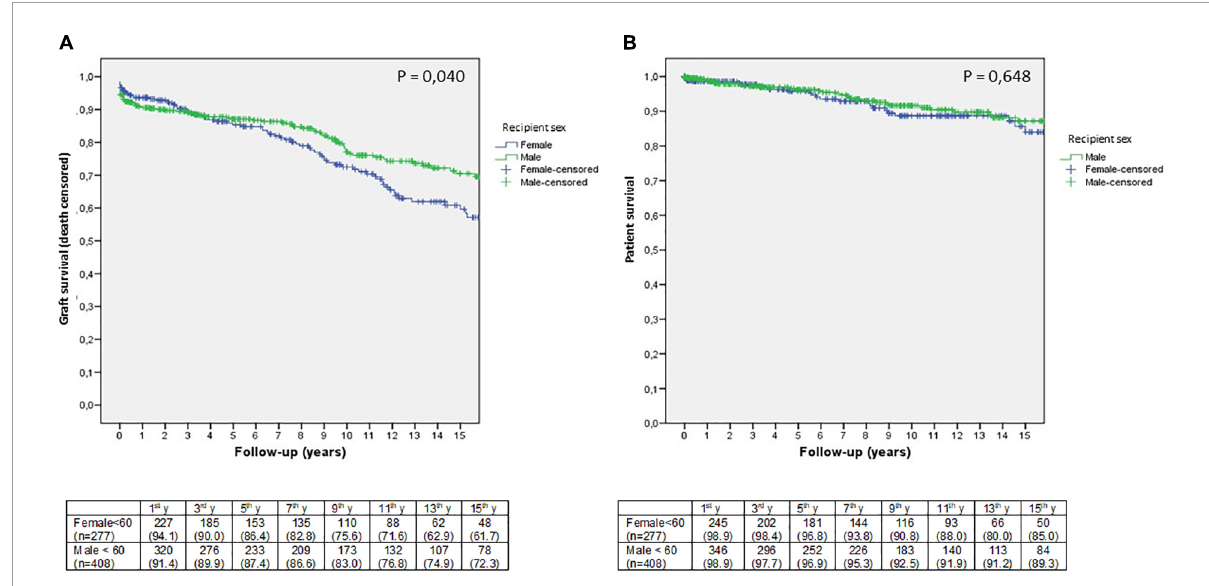
FIGURE2 Kaplan-Meier estimates of death-censored graft (A) and patient survival (B) according to recipient sex in adults younger than 60 years. The number of patients at risk during follow-up is indicated in the table below the figures ( n =